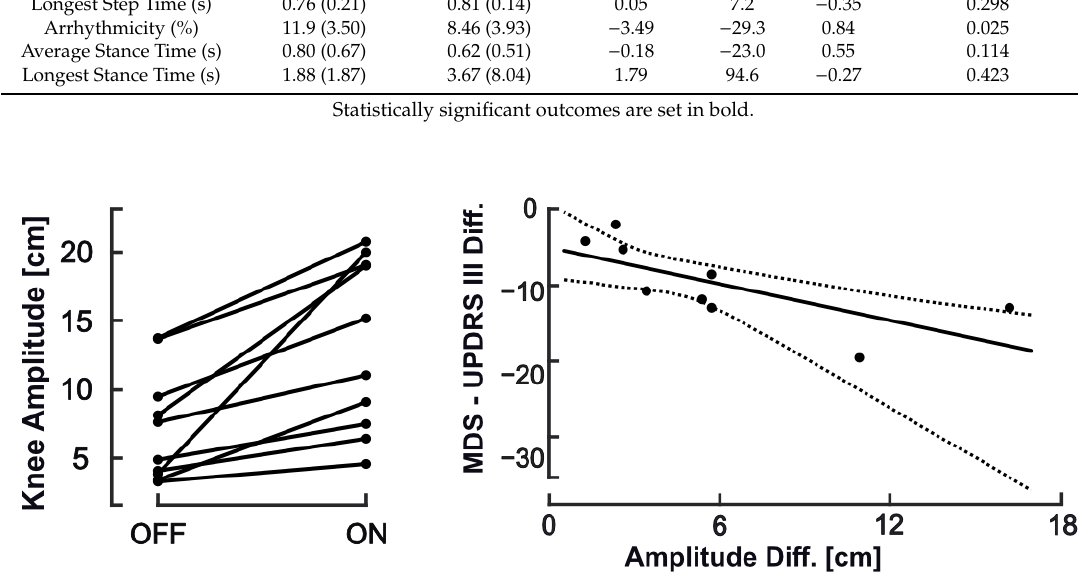
Figure 4. Changes of knee amplitude between treatment states (left) and knee amplitude changes related to disease severity change.